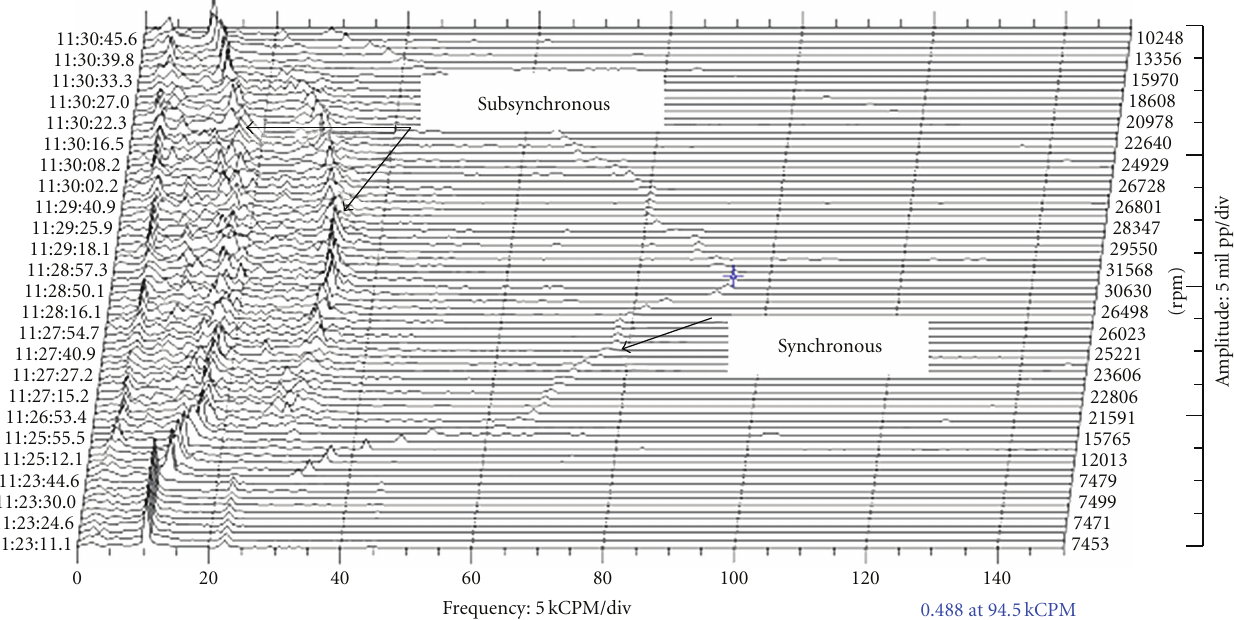
Figure 2: Waterfall frequency spectrum of a typical diesel engine turbocharger.